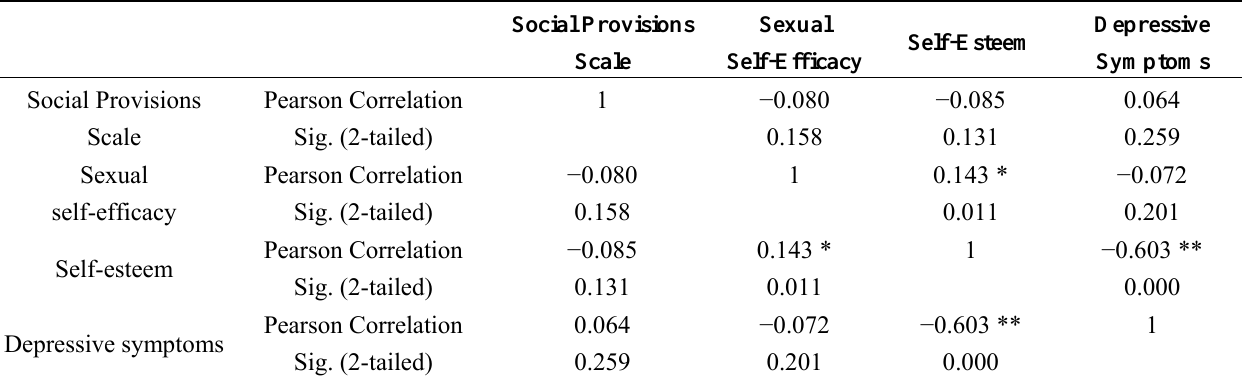
Table 2. Correlation Coefficients.